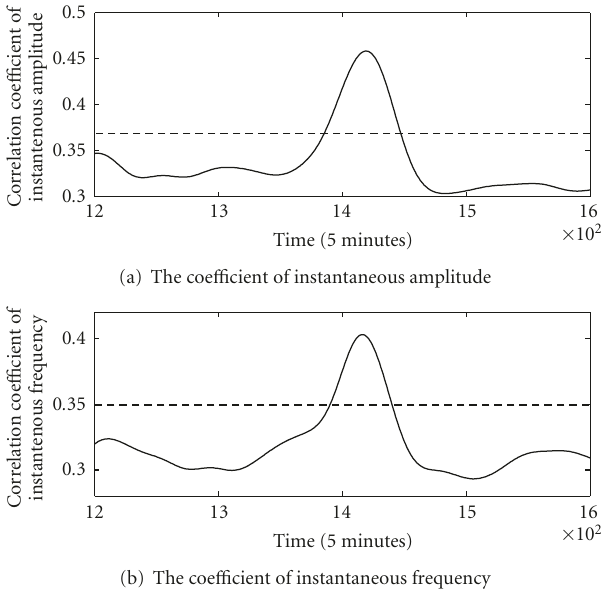
Figure 14: The detection results of 3rd week.